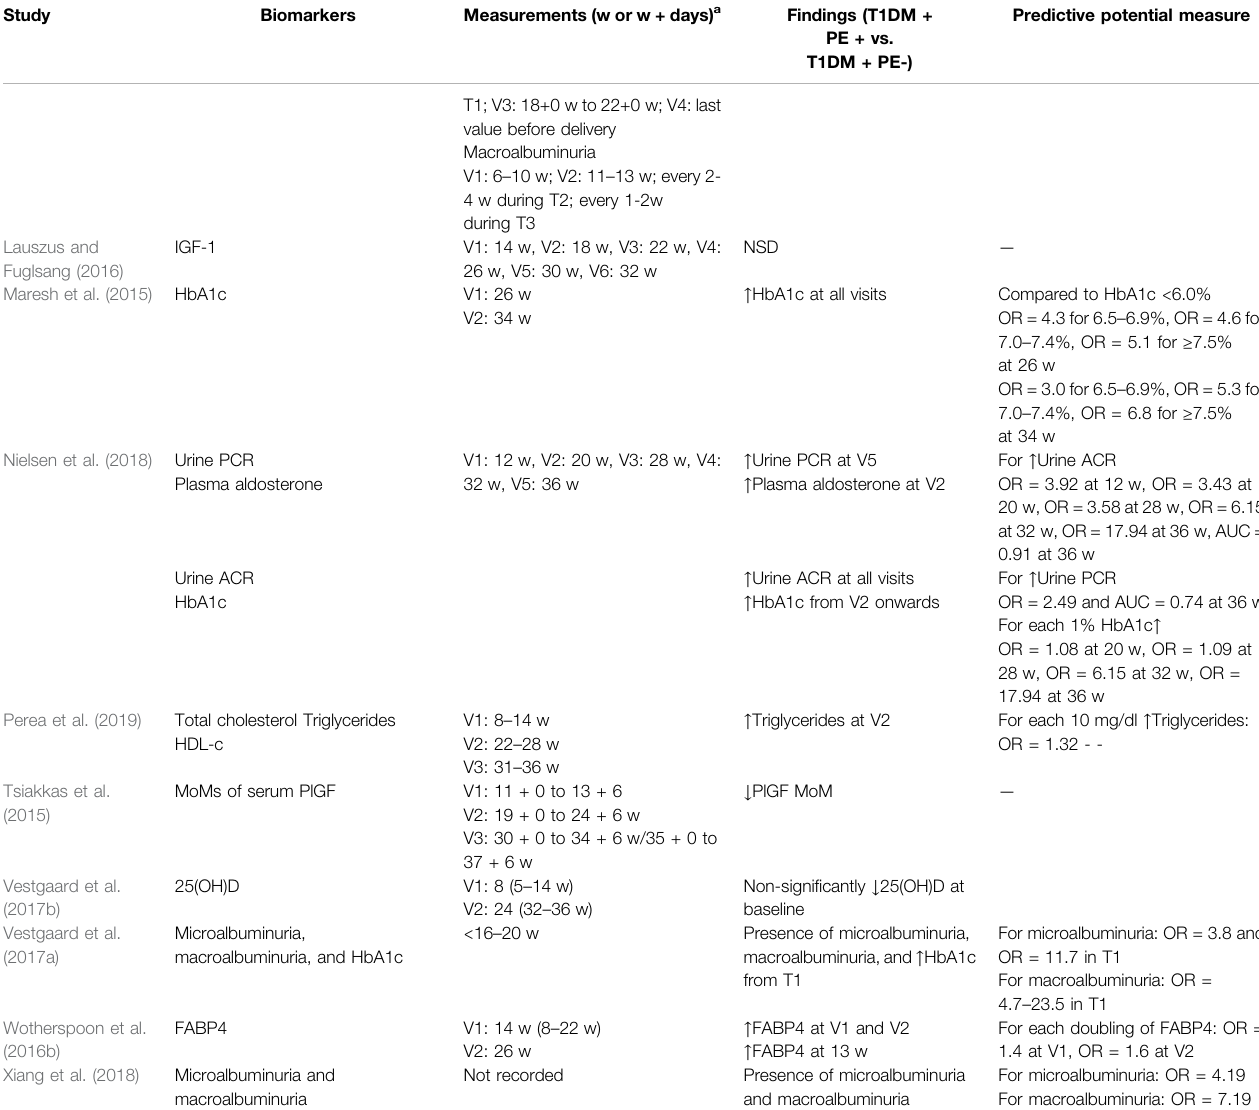
TABLE 3 | ( Continued ) Narrative synthesis of biomarkers for pre-eclampsia prediction in women with pregestational